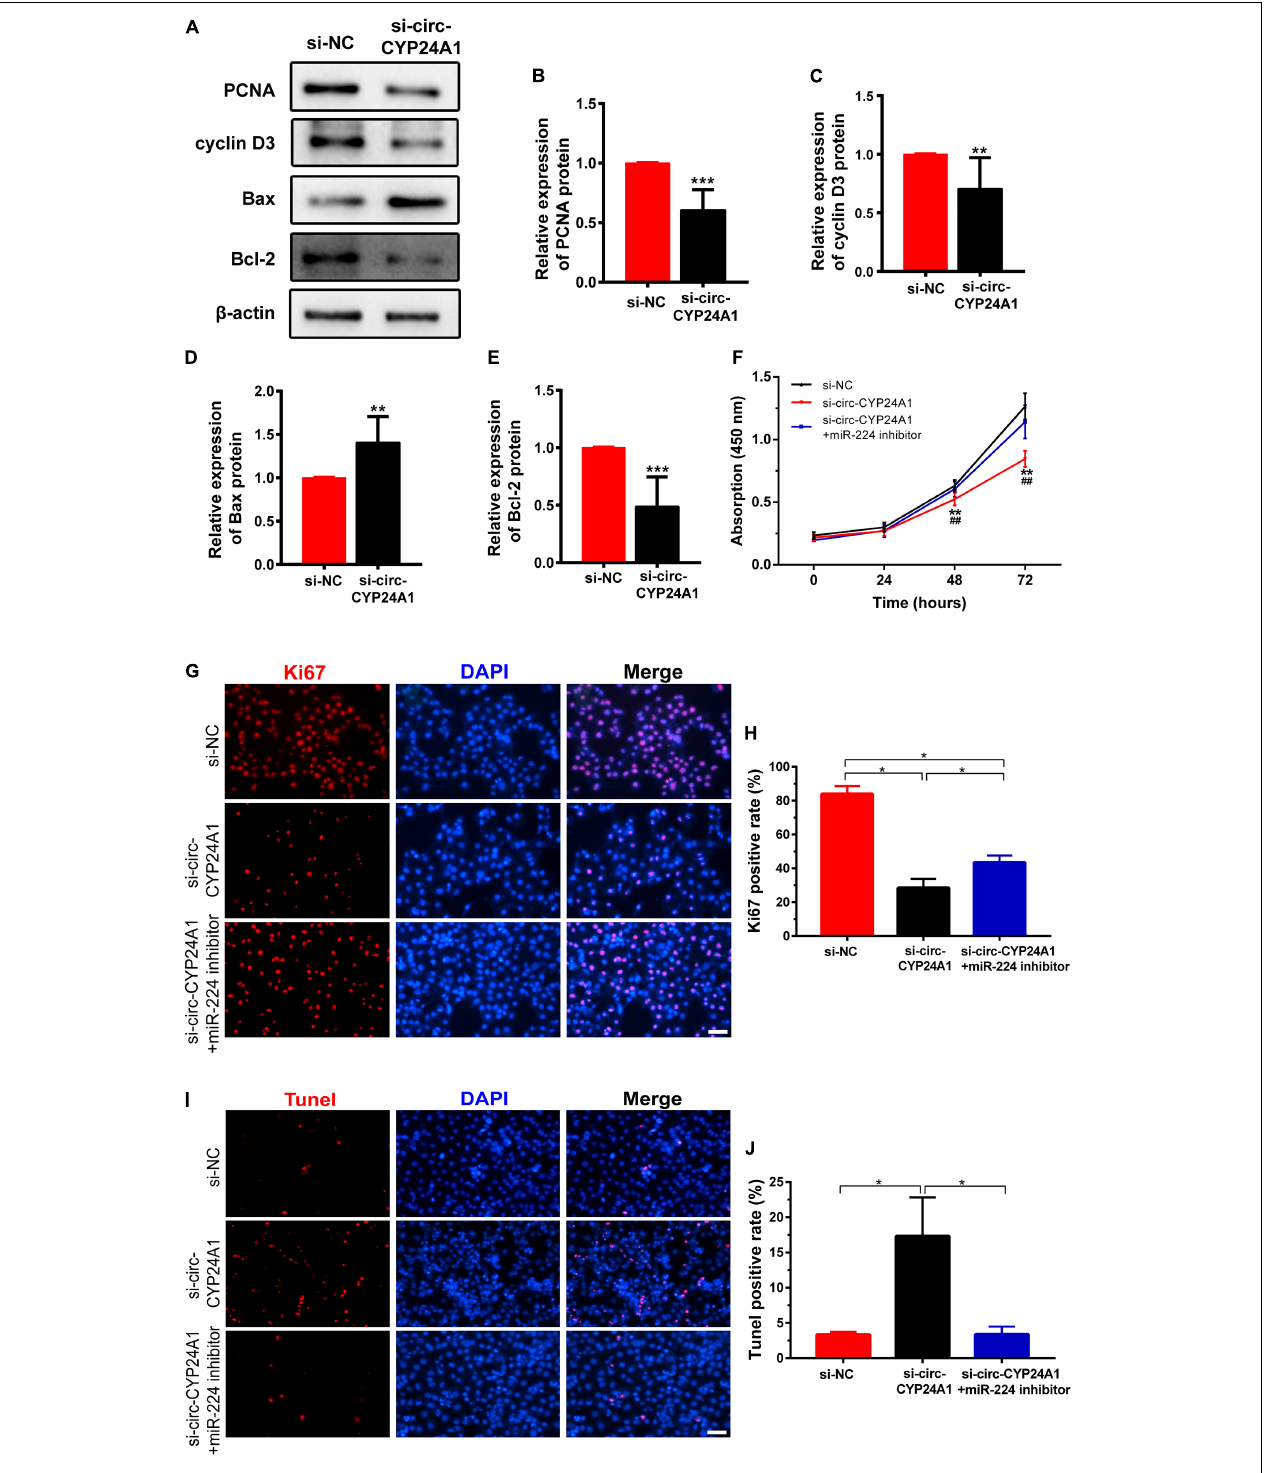
FIGURE 5 | Circ-CYP24A1 regulated cell proliferation and apoptosis via the miR-224_PRLR axis. (A) Expression of proliferation-related markers was detected using Western blotting in Ishikawa cells transfected with circ-CYP24A1 siRNA. (B–E) Gray analysis of A. (F) Cell viability was detected in Ishikawa cells transfected with circ-CYP24A1 siRNA or co-transfected with circ-CYP24A1 siRNA and miR-224 inhibitor using the CCK8 assay. (G) Immunofluorescence staining for Ki67 in Ishikawa cells. (H) Quantitative group data for Ki67 positive cells. (I) Apoptosis in Ishikawa cells was tested using the TUNEL assay. (J) Quantitative group data for TUNEL positive cells. RM, early recurrent miscarriage; control, unintended pregnant women; si-NC, negative control to siRNA; #, comparison between si-circ-CYP24A1 and si-circ-CYP24A1 + miR-224 inhibitor (** p < 0.01, *** p < 0.005, ## p < 0.01). Scale bar: 100 µ m.